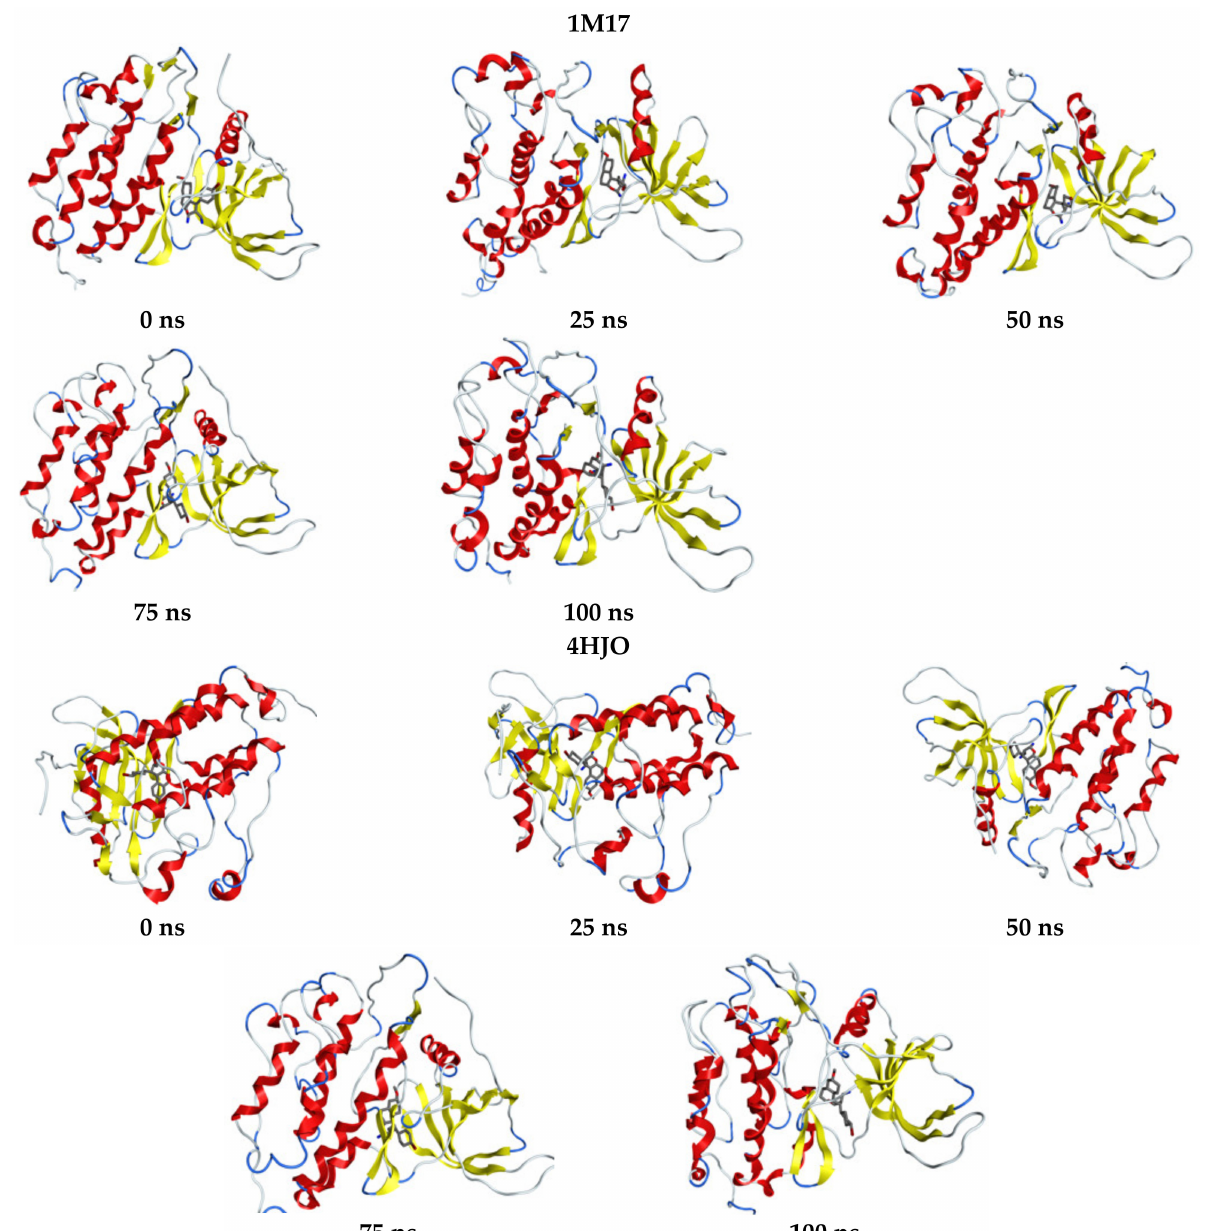
Figure 9. Snapshots of compound 4 with the 1M17 and 4HJO enzymes at different nanoseconds. The “solvent-accessible-surface-area, SASA” simulation was studied for the investi- gated complexes to study the variation in the topology of the complexes, where the higher SASA learns the extent of the surface volumes. Lower SASA is defined by the elongated nature (Figure 9). The steady-state for 1M17 and 4HJO after 13 ns and the low variation degree for the SASA profiles along the simulation trajectories demonstrated their stable nature. Furthermore, all complexes had nearly the same SASA degree and described the condensed form of these protein complexes during the interaction of compound 4. Fur- thermore, the slight deviation for MM-PBSA for the overall time-scale, showed the strong interaction between the ligand and amino acid backbone for proteins, which showed a firm H-bonding pattern. The system behavior can be explained by the regularly changed binding pose of the compound at the binding pocket of the enzyme, where the binding affinity was stronger and still produced good intermolecular interactions. The different snapshot of compound 4 with the enzyme is given in Figure